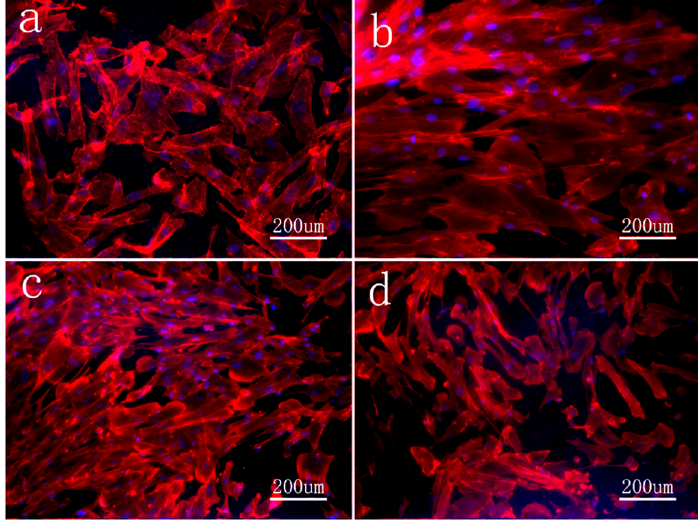
Figure 7. Immunochemistry of the cytoskeletonal integrity of attached cells examined using a fluorescent microscope. The different figures illustrated the similar culture density and morphology of the cells that were raised on coated titanium substrate, demonstrating the consistency in performance of enriched biomaterial. In addition, immunochemistry showed the very organized actin filaments in all of the cells, and their stretch